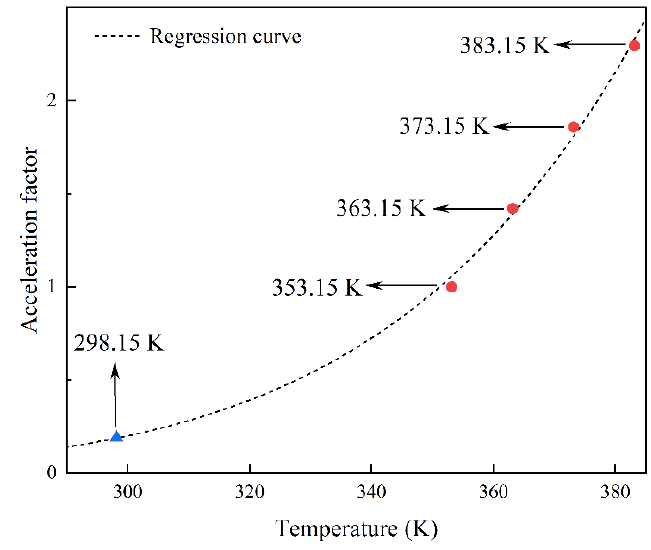
Figure 4. Regression and extrapolation results of the acceleration factors.